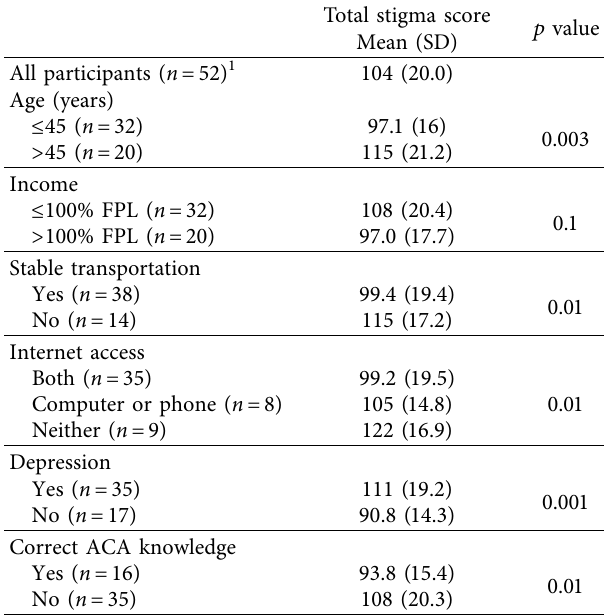
Table 3: Stigma score compared to selected baseline characteristics and correct Affordable Care Act